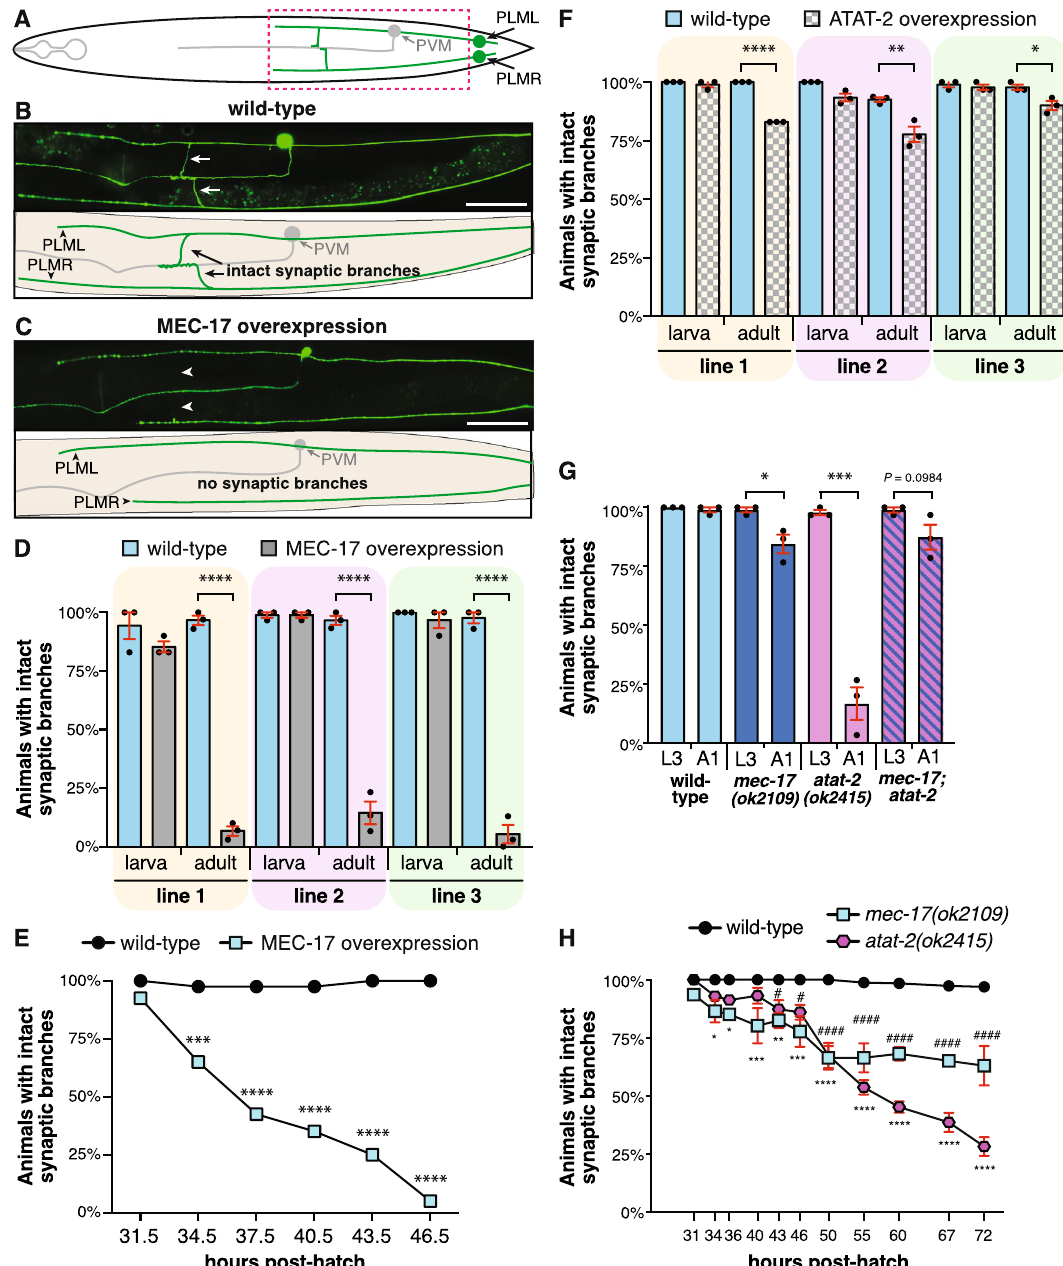
Figure 1. Overexpression and loss of MEC-17 and ATAT-2 disrupts the PLM synaptic branches. ( a ) Schematic representation of a ventral view of the PLM (green) and PVM neurons (gray). Dashed box highlights the approximate location of the regions imaged in ( b,c ). ( b ) Image and schematic showing the intact PLM synaptic branches of a wild-type animal carrying the zdIs5(Pmec-4::GFP) transgene. Arrows point to the synaptic branches of PLM left (PLML) and PLM right (PLMR). ( c ) Image and schematic of an animal with overexpression of MEC-17 in which the synaptic branches of both PLML and PLMR are disrupted. Arrowheads point the expected position of the lost branches. Scale bars represent 50 µm. ( d ) Quantification of the number of animals with intact synaptic branches at L3 (larva) or A1 (adult) stages. Three independent transgenic strains are shown (gray bars) compared to their non- transgenic siblings (wild-type, blue bars). Bars show mean ± SE; symbols show the mean of three-independent experiments, each with n ≥ 30 (total n ≥ 90). ( e ) Quantification of the number of animals with an intact synaptic branch across the L4 stage of development in animals carrying the same transgene as line 3 in ( d ) ( cjnEx036(Pmec-4::mec-17) ; blue squares) compared to their non-transgenic siblings (wild-type, black circles). Different groups of animals were analyzed for each time-point; n ≥ 36 for each time-point. ( f ) Quantification of the number of animals with an intact synaptic branch at L3 (larva) or A1 (adult) stages. Three independent transgenic strains with overexpression of ATAT-2 (gray bars) or their non-transgenic siblings (wild-type, blue bars) are shown. Bars show mean ± SE; symbols show the mean of three-independent experiments, each with n ≥ 28 (total n ≥ 89). ( g ) Quantification of the number of animals with intact synaptic branches in mec-17(ok2109) and atat-2(ok2415) single and double mutant backgrounds at both L3 and A1 stages. Bars show mean ± SE; symbols show the mean of three-independent experiments, each with n ≥ 29 (total n ≥ 90). ( h ) Quantification of the number of animals with intact synaptic branches across different time-points of development in wild-type animals compared to those lacking mec-17 or atat-2 . Different groups of animals were analyzed for each time-point; n ≥ 20 for each time-point (total n ≥ 72). P values * < 0.05, ** < 0.01, *** < 0.001, **** < 0.0001 from one-way ANOVA with Tukey’s post-hoc tests ( d,f ), Fisher’s exact test ( e ) or unpaired t -tests ( g